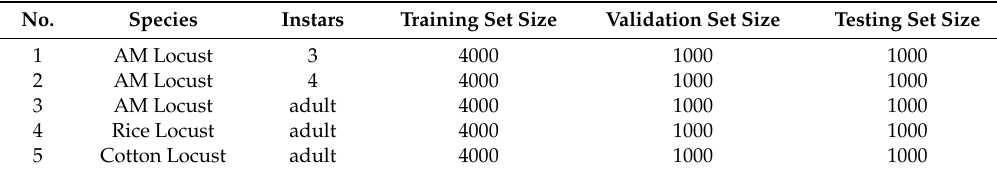
Table 1. Sample data sets for classification experiments.